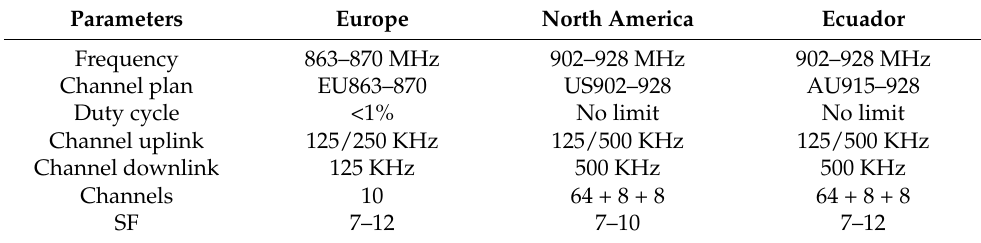
Table 2. Comparative LoRa frequency chart for Europe, North America, and Ecuador. Parameters